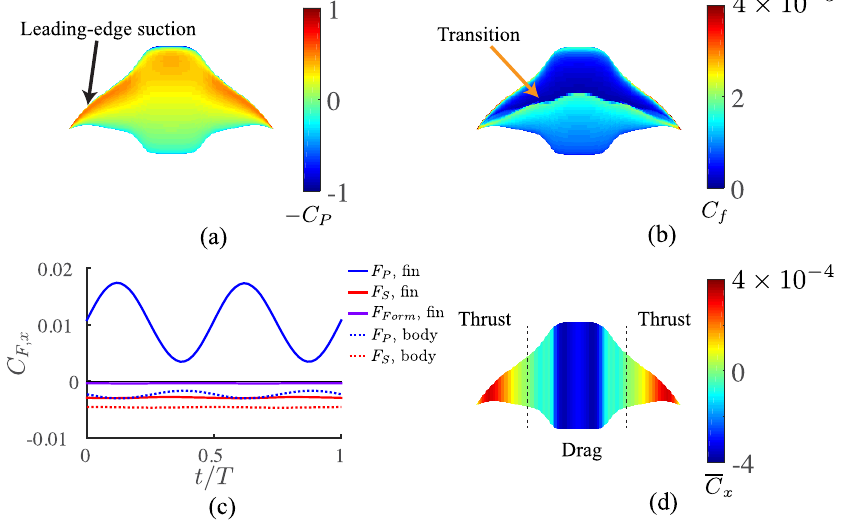
Figure 14. ( a ) Time-averaged pressure coefficient distribution over the manta ray; ( b ) Time-averaged skin friction coefficient distribution over the manta ray; ( c ) Time-varying forces decomposed into pressure forces acting on the fins and body and shear forces acting on the fins and body. The form drag (pressure force) acting on the fins is also included; ( d ) Time-averaged net force coefficient integrated over chordwise strips.